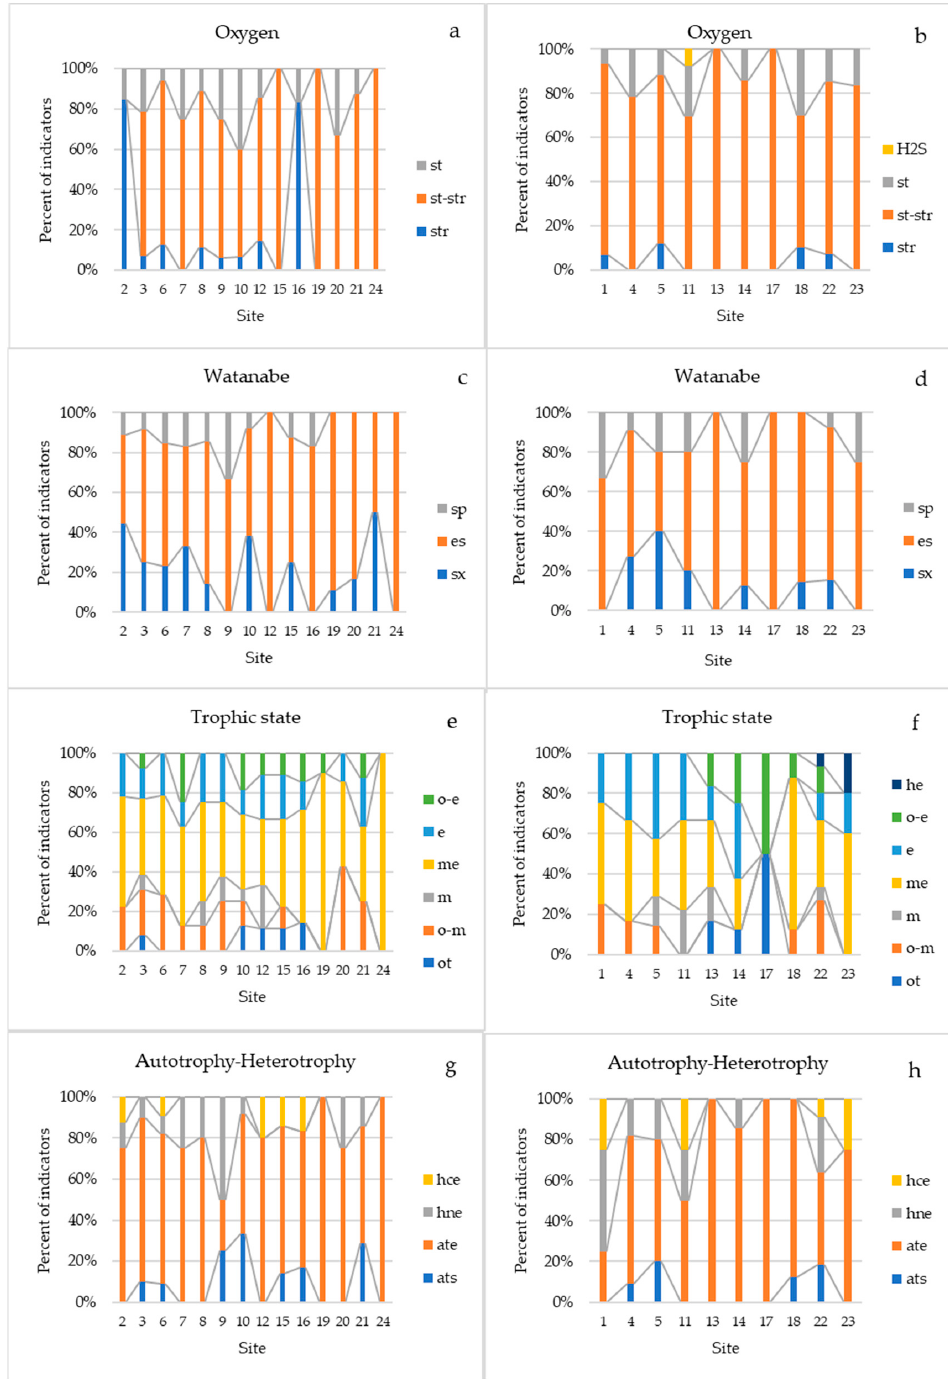
Figure 8. Ecological characteristics of phytoplankton species indicators (oxygenation, organic pollution by Watanabe, trophic state and nitrogen uptake metabolism) grouped according to the size of the rivers, S and M ( a , c , e , g ) and L and XL ( b , d , f , h ), in the Siversky Donets river basin (Ukrainian part). Abbreviations of ecological groups: by oxygenation, st—standing water, str—streaming water, st-str—low streaming water, and H 2 S—sulfide indicators; by saprobity, sx—saproxenes; es—eurysaprobes; sp—saprophiles; by trophic state, ot—oligotraphentes, o-m—oligo-mesotraphhentes; m—mesotraphentes; me—meso-eutraphentes; e—eutraphentes; o-e—from oligo to eutraphentes; by nutrition type, ats—strict autotrophes; ate—autotrophic withstand low nitrogen load; hne—partial heterotrophes (mixotrophes); hce—permanent mixotrophes needing nitrogen